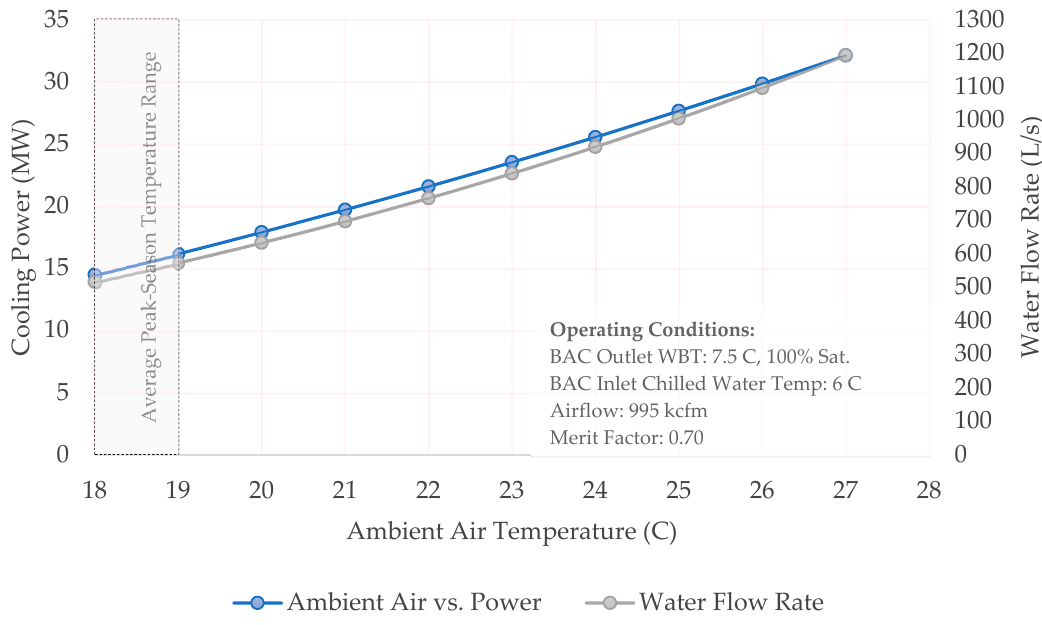
Figure 10. Surface plant design cooling sensitivity and required water delivery curves based on changing ambient air temperature (i.e., cooling power (blue), left, and flow rate (grey), right).